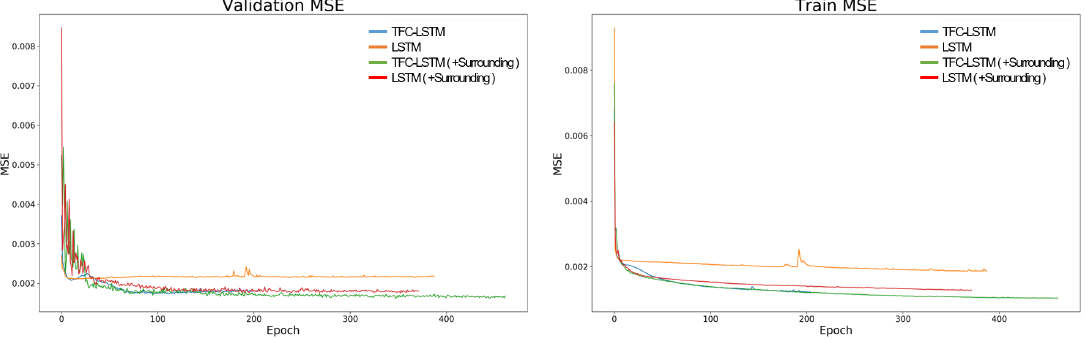
Figure 10. MSEs during training and